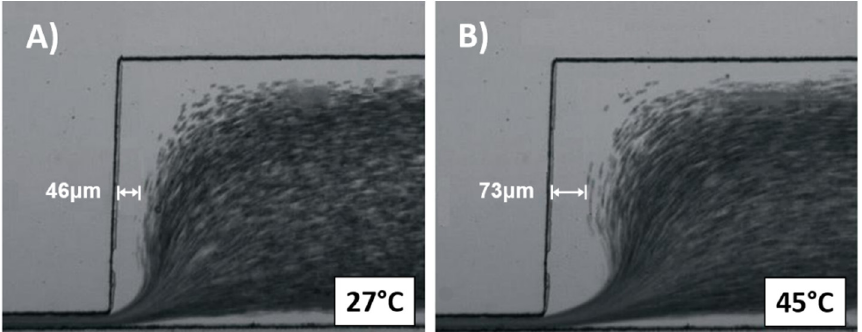
Figure 7. Images of RBCs suspended in plasma at ( A ) 27 °C and ( B ) 45 °C. The measurements are taken in the central section of the outlet channel.